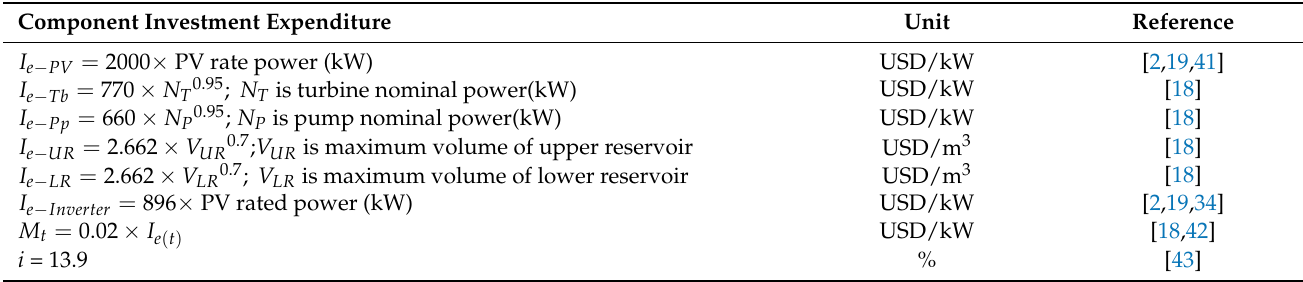
Table 2. Investment expenditure for each component of the